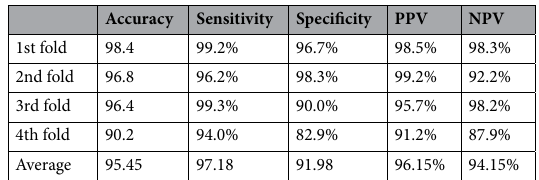
Table 5. Results of fourfold cross validation of TAP-CRNN.